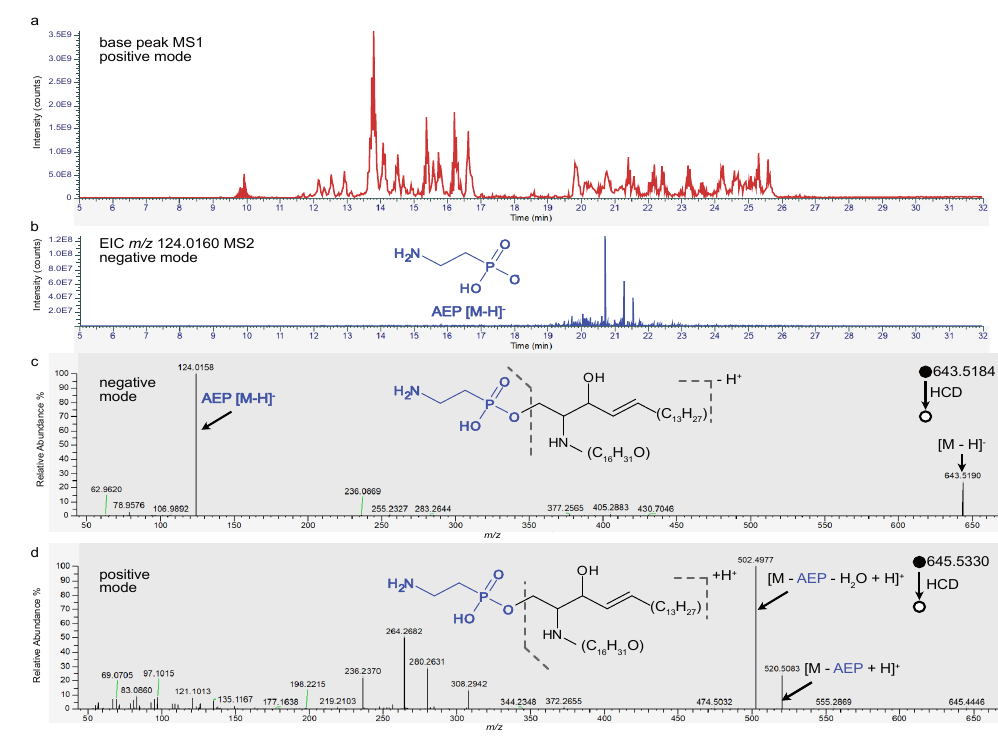
Figure 1 Mussel extracts contain a high number of phosphonolipids. (A) LC-MS chromatogram (base peak) of M. edulis gill tissue extract, measured in positive mode. (B) Ion trace for the 2- aminoethylphosphonate (AEP) headgroup m/z 124.0160 ± 5 ppm in all acquired MS2 scans (negative mode). Putative identification of phosphonolipid PnE-Cer 34:1 (exact mass 644.525711) in (C ) negative ionization mode ( m/z 643.5184 [M-H] − ) and (D) positive ionization mode ( m/z 645.5330 [M+H] + ). Indicative AEP occurs as neutral loss in positive ionization mode and as fragment ion in negative ionization mode ( m/z 124.01). Full-size DOI: